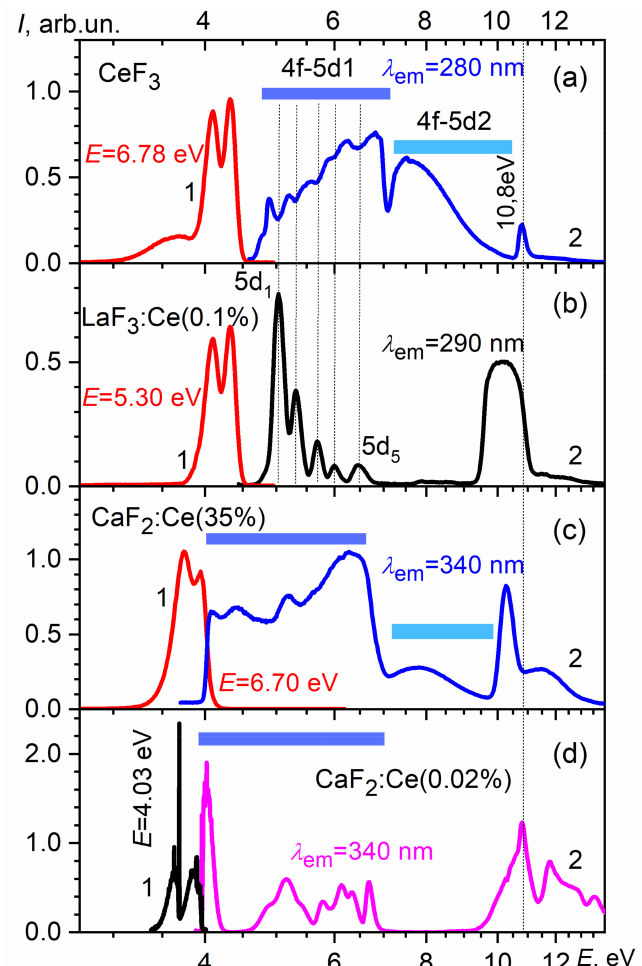
Figure 3. Luminescence (curves 1) and luminescence excitation spectra (curves 2) for: ( a ) 4f-5d cerium excitons in CeF 3 ; ( b ) Ce 3+ ions in LaF 3 :Ce; ( c ) CeF 3 phases in CaF 2 :Ce (35 wt.%); ( d ) Ce 3+ ions in CaF 2 : Ce (0.02 wt.%). T = 10